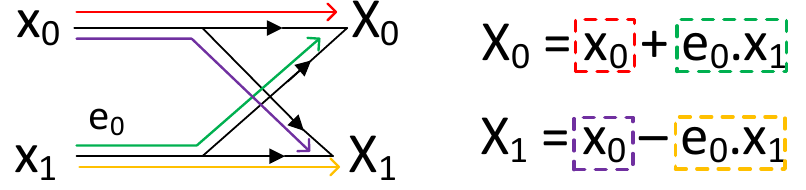
Figure 2. Simple butterfly